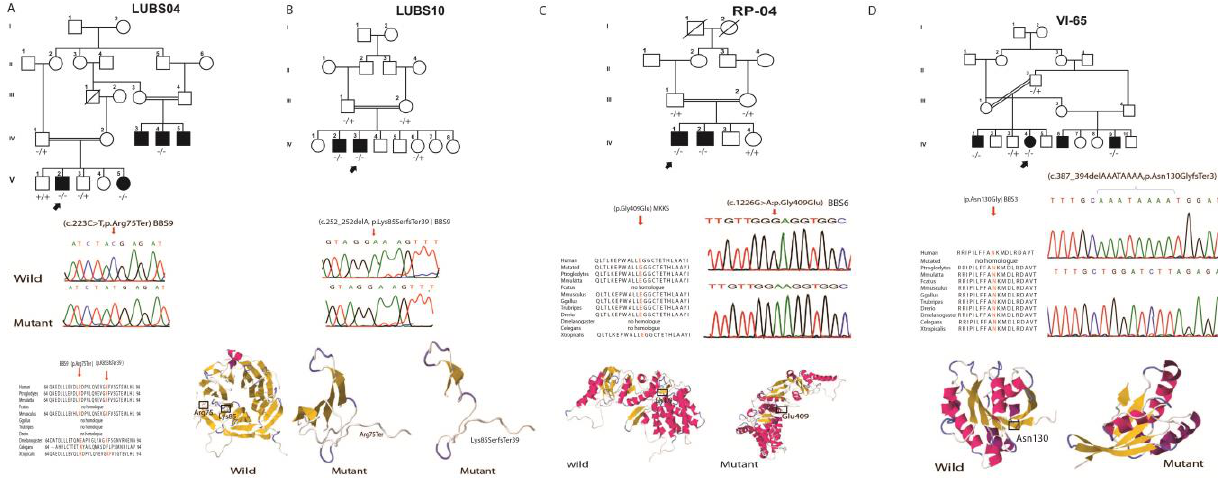
Figure 2. Bardet-Biedl Syndrome affected Pedigrees with novel variations showing chromatogram along with the wild type and mutant protein models.